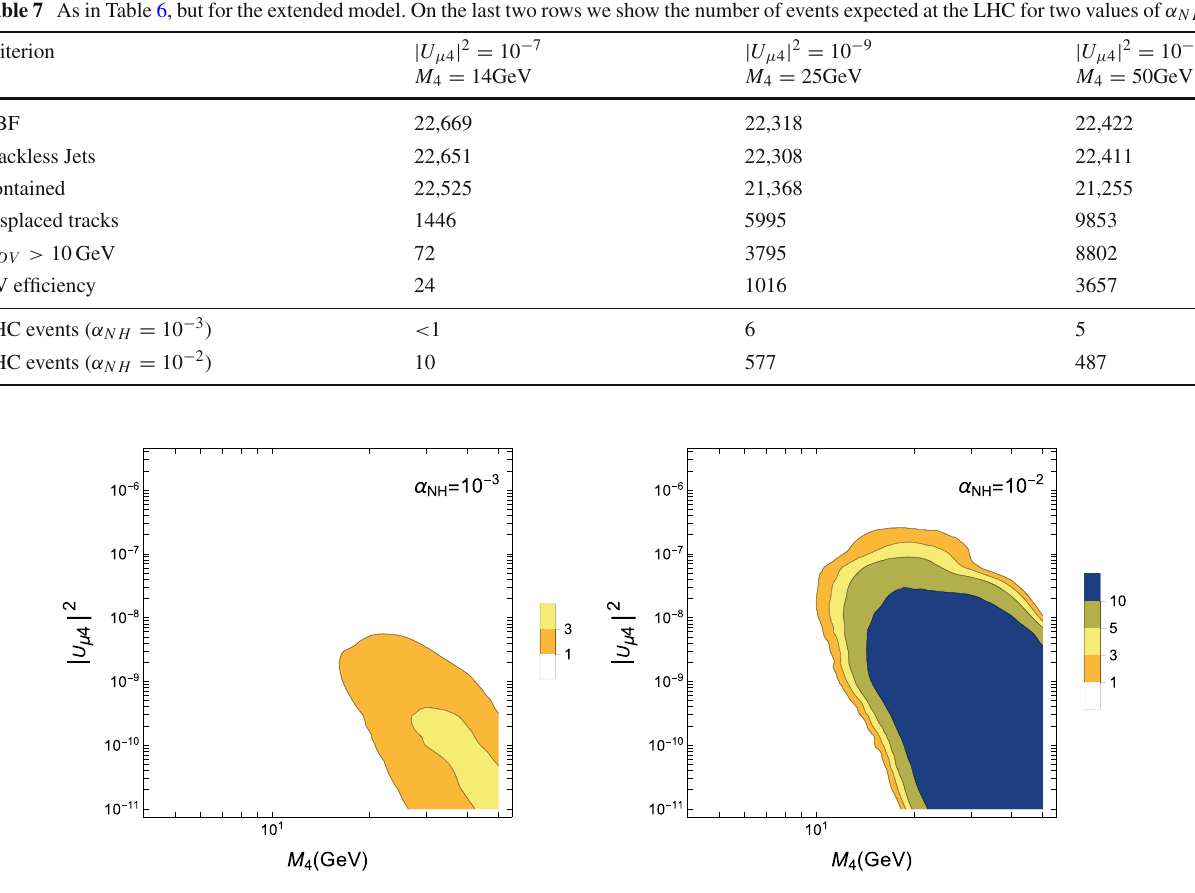
surviving the displaced tracks cut are those with at least five tracks with